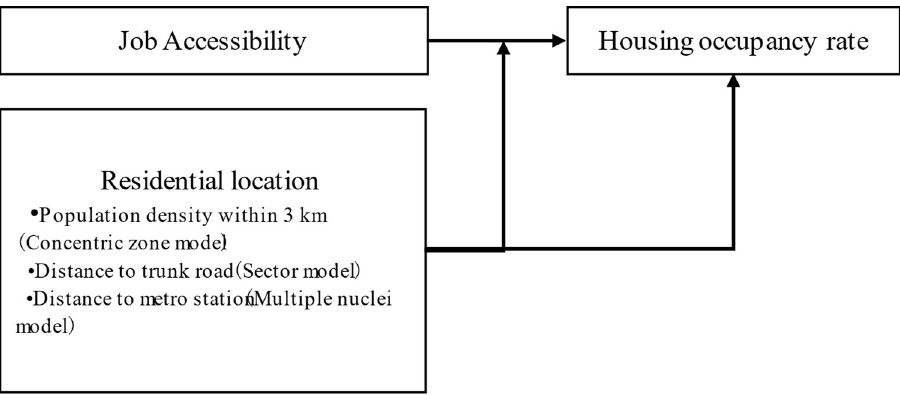
Figure 1. Conceptual framework.